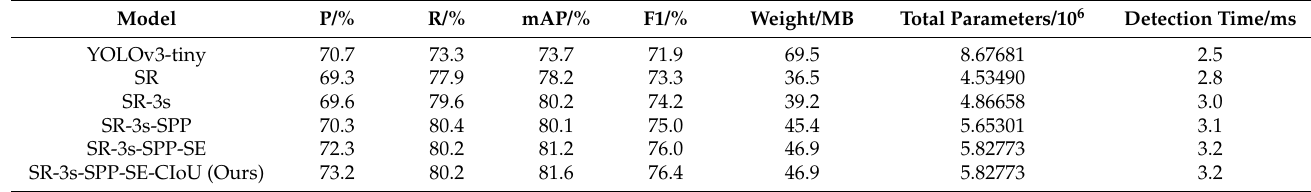
Table 3. Ablation results of different models on the validation